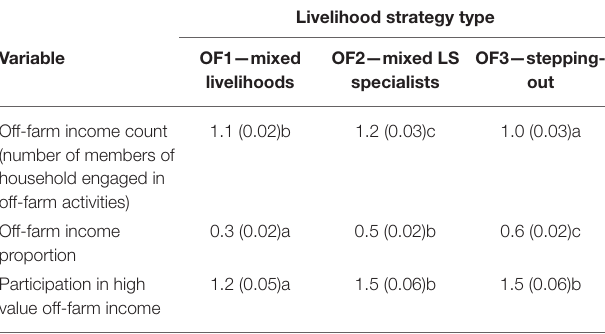
TABLE 4 | Estimated marginal means for off-farm income activity variables of the different household livelihood strategy types incorporating off-farm income activities #